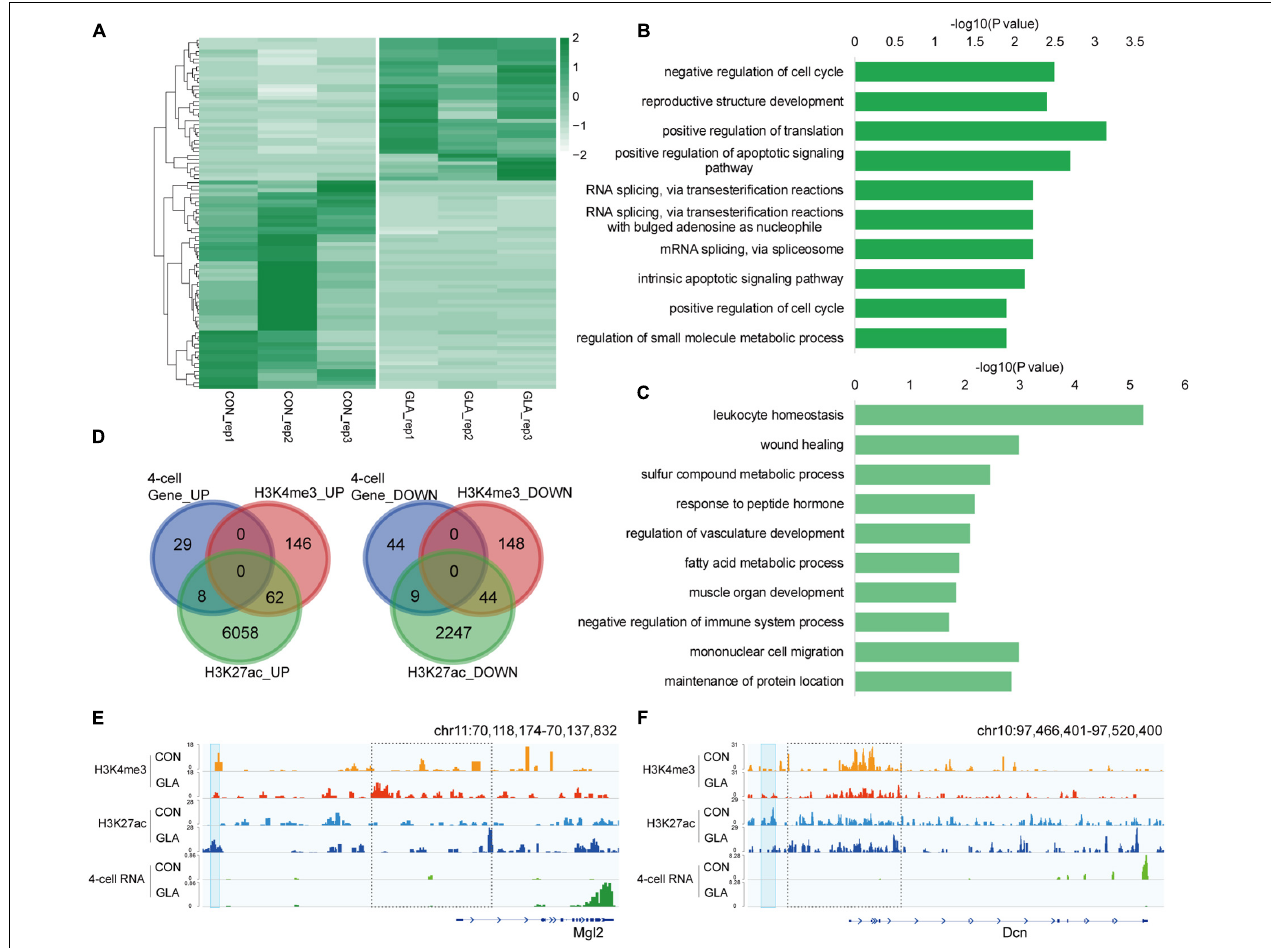
FIGURE 5 | Differential gene expression in 4-cell embryos in connection with H3K4me3 and H3K27ac alterations in GLA sperm. (A) Heatmap of normalized gene expression levels in CON and GLA 4-cell embryos. (B,C) Selected significant pathways from Gene Ontology analysis on up-regulated (B) or down-regulated (C) genes in GLA 4-cell embryos. (D) Venn diagram showing the number of regions with different gene expression levels in GLA 4-cell embryos that overlap regions with altered H3K4me3 and H3K27ac levels in GLA sperm. Left, up-regulated regions overlapping regions with increased H3K4me3 and H3K27ac. Right, down-regulated regions overlapping regions with decreased H3K4me3 and H3K27ac. (E) Integrative Genomics Viewer tracks showing up-regulated Mgl2 in 4-cell embryos integrating with H3K4me3 and H3K27ac signals in GLA sperm. (F) Integrative Genomics Viewer tracks showing down-regulated Dcn integrating with H3K4me3 and H3K27ac signals in GLA sperm. Blue box indicates regions with differential H3K27ac signals ( P -value < 0.05). Dashed box indicates regions with slightly differential histone methylation